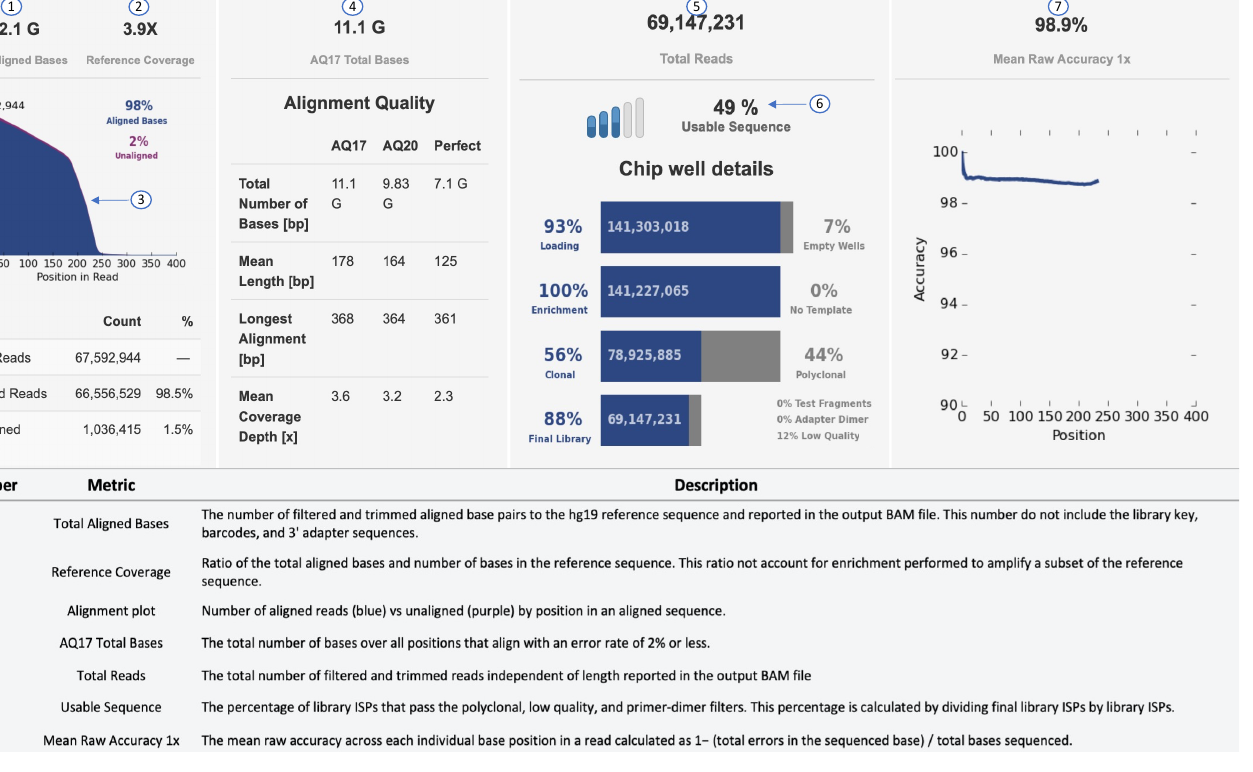
Table 4. Comparison between next-generation sequencing and Sanger sequencing.